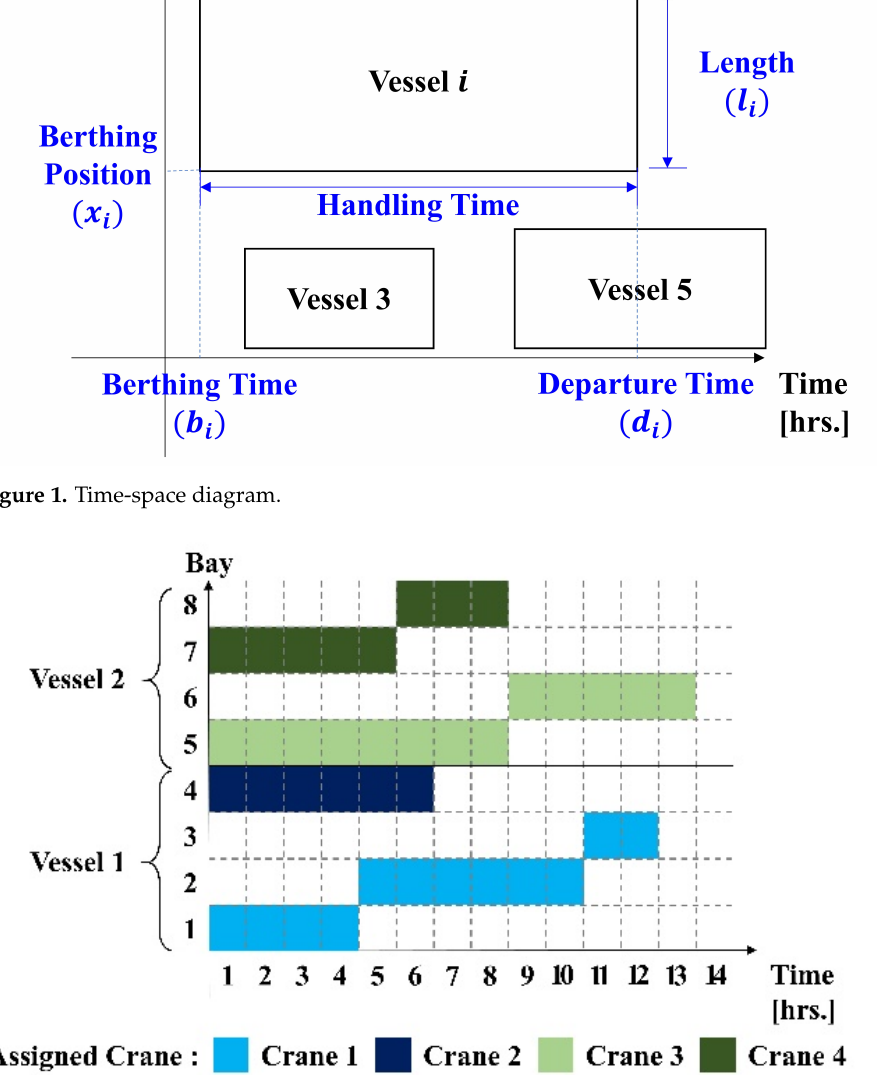
Figure 2. An example of QCAP.